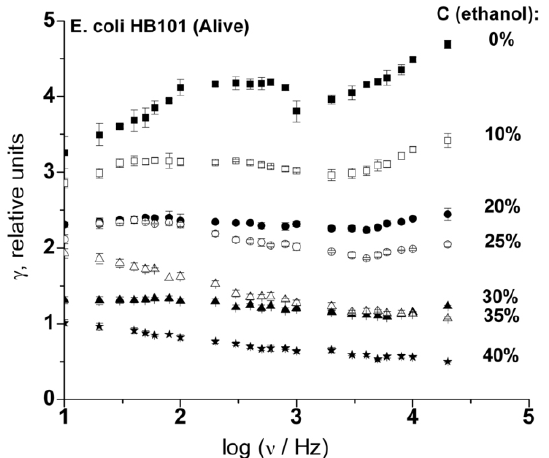
Figure 3. Frequency dependencies of the electric polarizability ( γ ) of E. coli HB101 (live) cells at different ethanol concentration in the range 0-40 vol.%.